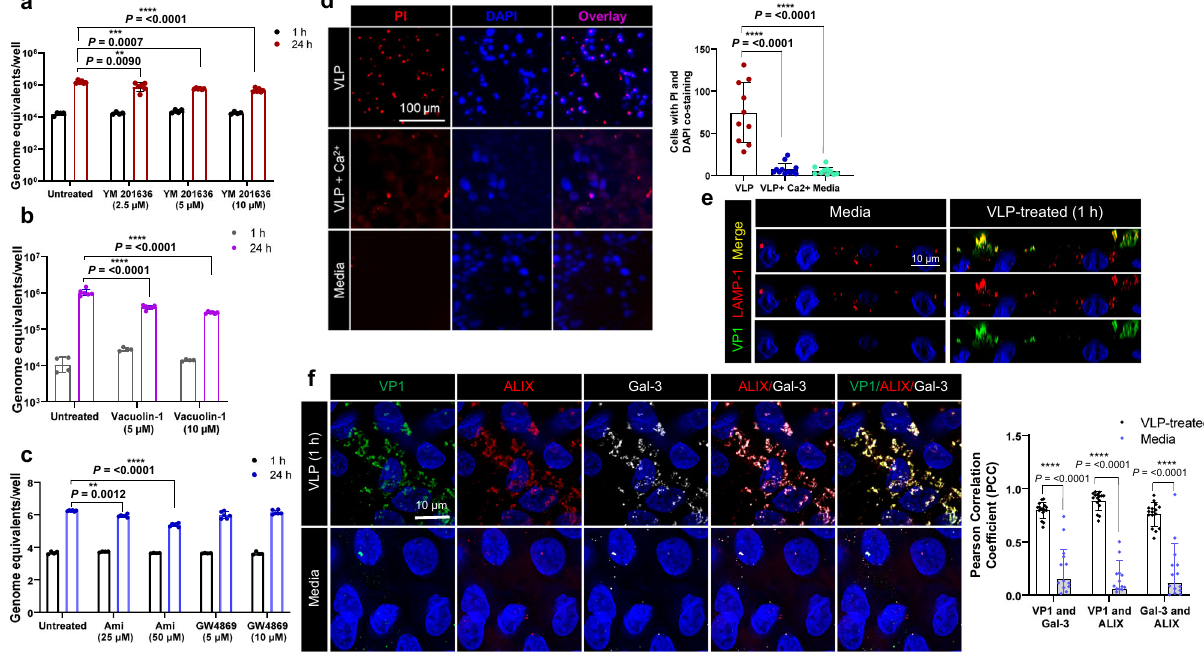
Fig. 5 | GII.4 entry is sensitive to factors controlling endo-lysosomal home- ostasis and induces membrane wounding and subsequent wound repair mechanisms. a GII.4 replication in the presence of PIKfyve inhibitor YM201636 at 1h(black)and24h(red)at37 o C. b GII.4replicationinthepresenceofvacuolin-1(a lysosomalexocytosisinhibitor)at1h(gray)and24h(purple). c GII.4replicationin the presence of acid sphingomyelinase (ASM, amitriptyline) and neutral sphingo- myelinase (NSM, GW4869) inhibitors at 1h (black) and 24h (blue). d Cell injury determination using propidium iodide (PI) uptake assay. Right panel: Graph quantitating membrane injury calculated by counting number of PI spots (red) counterstained with DAPI (blue) when HIEs were incubated with VLPs (ROI=10), VLP+Ca 2+ (ROI=12) and media (ROI=10). Signi fi cance was calculated using two- way ANOVA, Tukey ’ s multiple comparisons test. e Immuno fl uorescence staining showingGII.4-inducedlysosomalexocytosisrepresentedbythepresenceofLAMP- 1 on the apical cell surface in media-treated cells compared to VLP-treated cells.